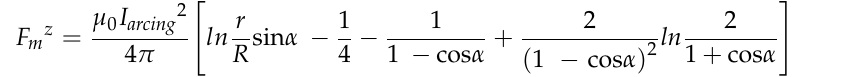
where I sc is the current in the CMT short-circuit phase and r 0 is the radius of the necking. The pressure near the electrode is greater than that near the substrate plate due to the uneven electromagnetic force inside the arc, and this pressure difference causes the particles